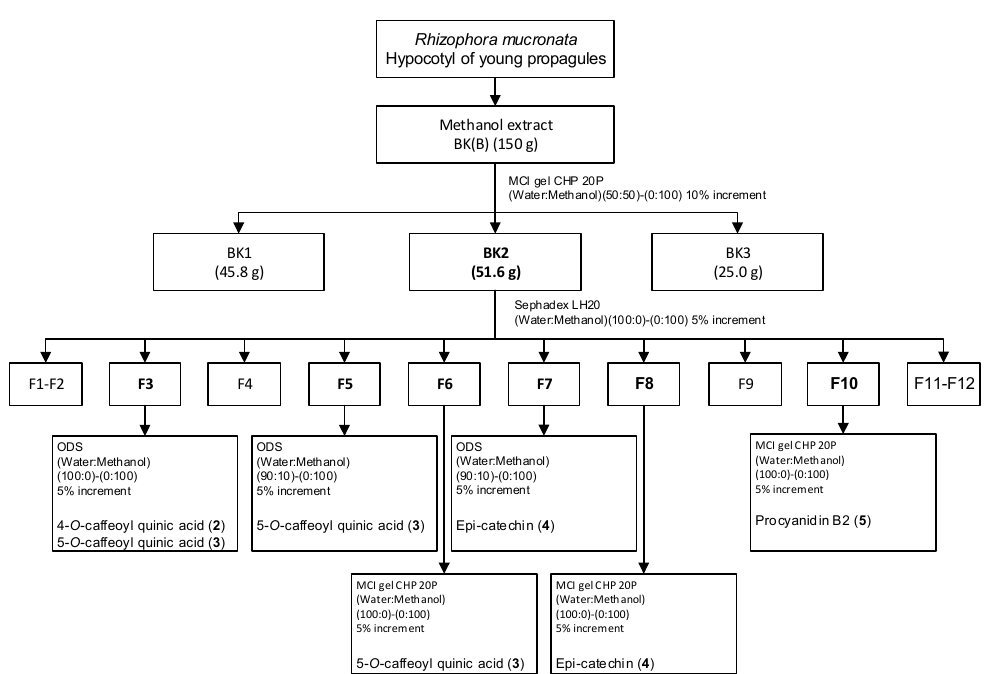
Figure 2. Isolation of compounds from the hypocotyl of young propagules. HPLC analysis: The chromatographic separation of the compounds in the extract was carried out with a Phenomenex Luna PFP(2) column (250 × 4.6 mm, 5 µ m, Phenomenex, USA) at room temperature. The solvent system consisted of mixtures of water with 0.1% formic acid (solvent A), acetonitrile (solvent B), and methanol (solvent C). Samples for HPLC analysis were filtered through a 0.45 µ m membrane filter. The optimized HPLC condition was as follows: 95–70% A, 5–20% B, and 0–10% C (0–50 min), 70% A, 20% B, and 10% C (50–55 min), 70–90% A, 20–10% B, and 10-0% C (55–60 min), 90% A and 10% B (60–65 min). The flow rate was 1.0 mL. The injection volume was 10 µ L with the extract dissolved in methanol at 20 mg/mL. Signal was monitored at 280 and 330 nm. Standards of 3- O -caffeoyl quinic acid (CAS 202650-88-2), 4- O -caffeoyl quinic acid (CAS 905-99-7), 5- O -caffeoyl quinic acid (CAS 906-33-2), and epi-catechin (CAS 490-46-0) were used for the identification of major peaks in the